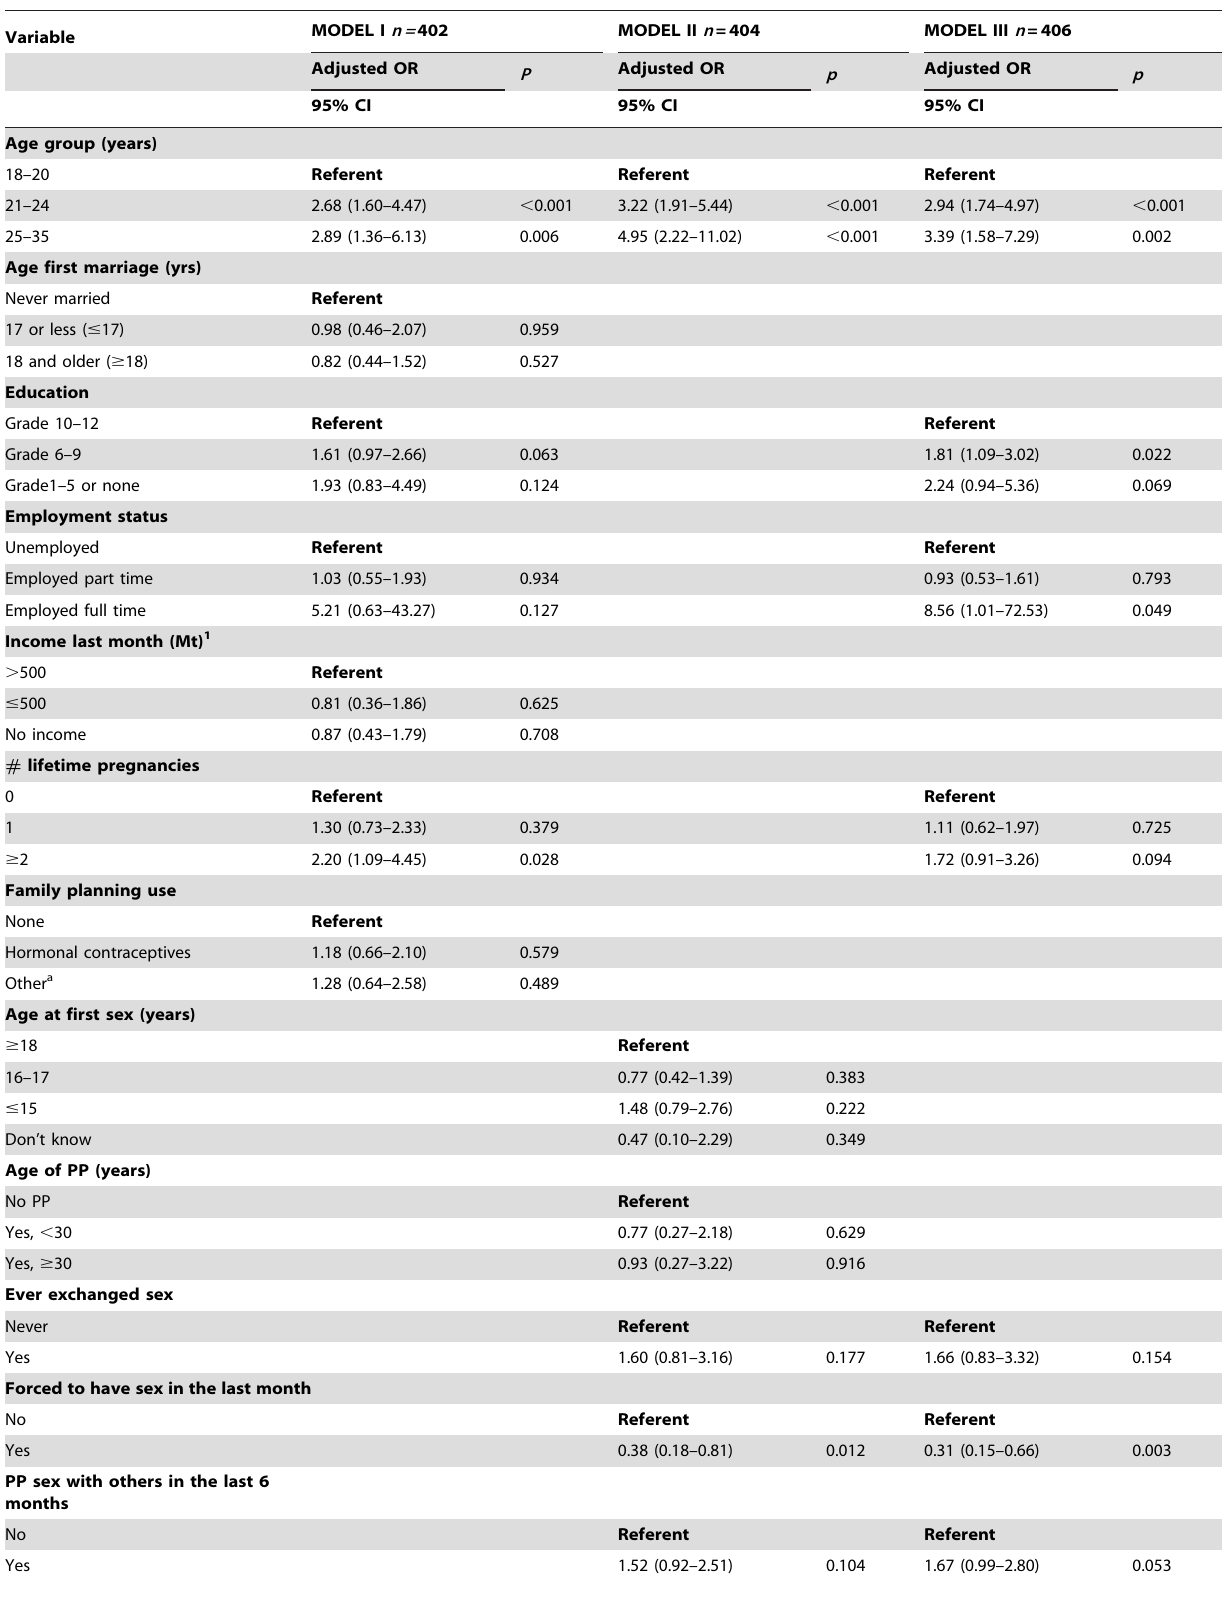
Table 2. Multivariable models of factors associated with HSV-2 prevalence in high risk women in Beira,